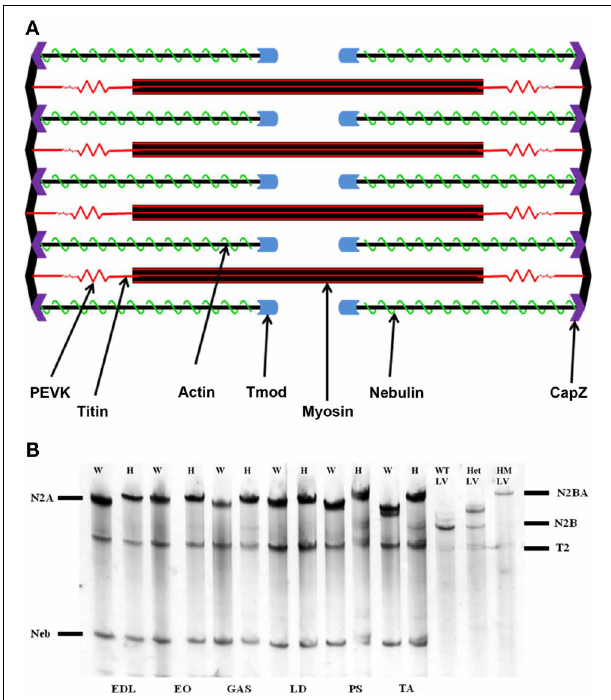
FIGURE 1 | (A) Schematic representation of the sarcomere. The actin thin filament is capped at its barbed end by CapZ, and at its pointed end by tropomodulin (Tmod). Nebulin runs along the thin filament to act as a stabilizing protein. (B) Agarose SDS gel showing skeletal muscle titin isoform expression. EDL, extensor digitorum longus; EO, external oblique; GAS, gastrocnemius; LD, longissimus dorsi; PS, psoas major; TA, tibialis anterior; W, rat left ventricle; HM LV, homozygote rat left ventricle. The N2BA isoform is found only within cardiac tissue, while the N2A isoform comprises the totality of skeletal muscle titin. The mutant rat phenotype exhibits a giant titin isoform of 3.9